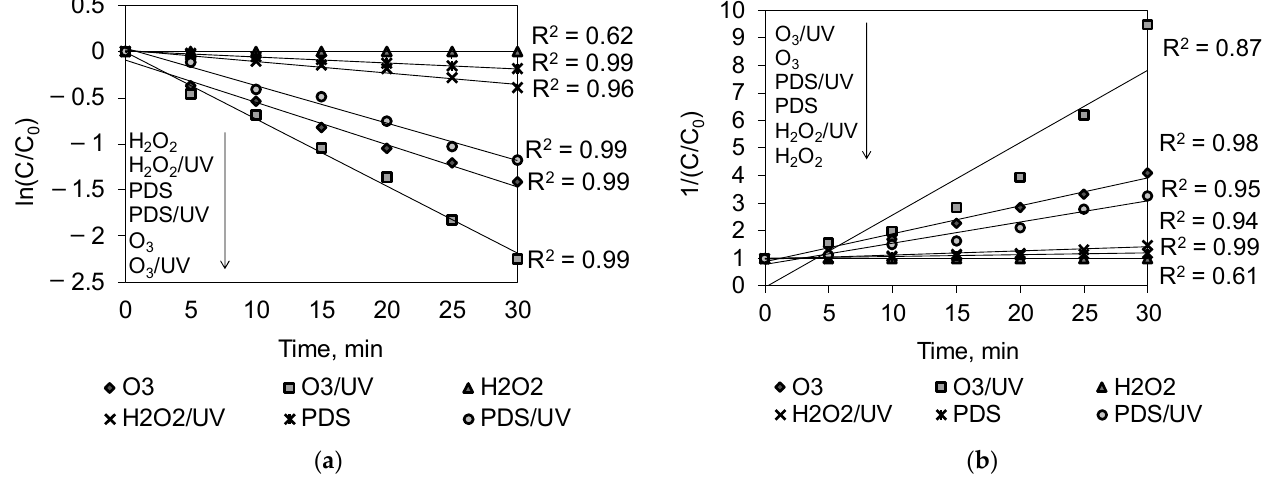
Figure 2. Kinetics of rhodamine B degradation ( a —pseudo-first-order; b —pseudo-second-order). Conditions: C 0[RhB] = 20.0 mg/L; V = 0.5 L; T = 298.0 K; p = 1013.0 hPa; pH = 6.0; t = 0–30 min.